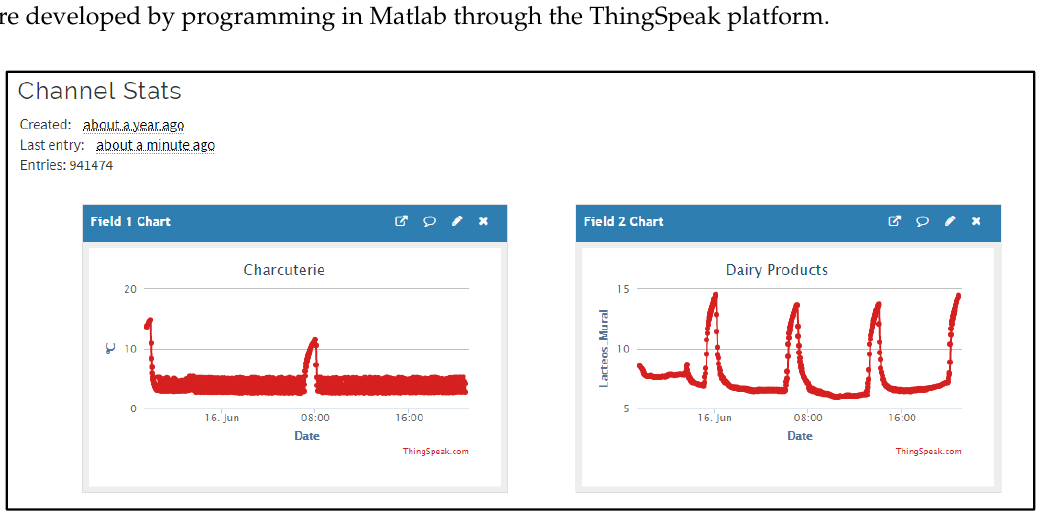
Figure 13. ThingSpeak visualization of temperature records associated to different display cabinets .